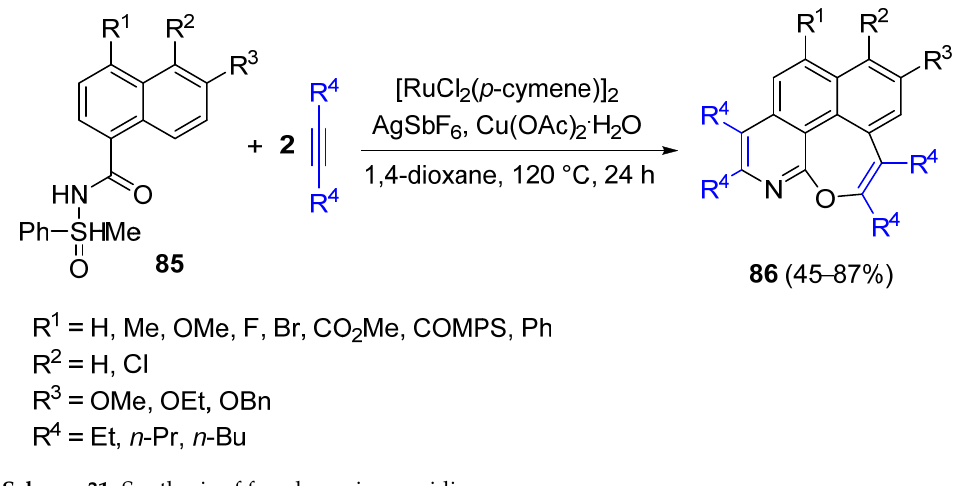
Scheme 30. Synthesis of